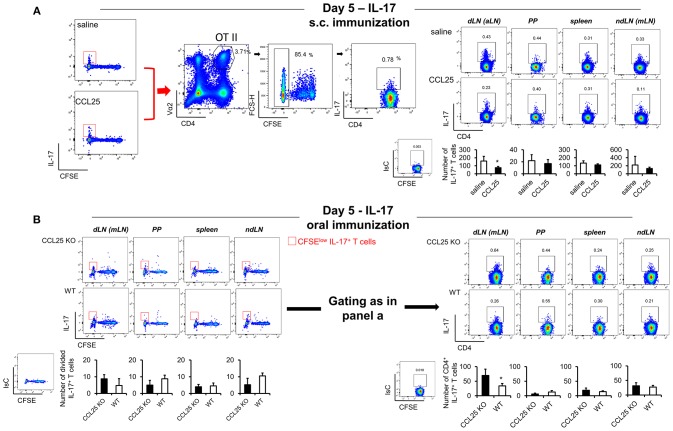
CCL25-induced TRM cells reduce differentiation of IL-17-producing T cells. OT-II naive T cells were labeled with CFSE (4 μM) and injected intravenously into syngeneic recipients (107/mouse), which were immunized 3 h later by s.c. (A) or oral (B) administration of 0.5 μg OVA-DEC plus 50 μg poly IC adjuvant (InvivoGen) re-suspended in saline solution or in the presence of CCL25 (0.06 mg/kg). T cells were separately harvested from draining LN (axillary, dLN), mesenteric LNs (mLNs), Peyer's Patches (PPs) and spleen 5 days later. Expression of IL-17 by T cells was assessed by flow cytometry by gating on CD4+Vα2+ (OTII TCR) CFSElow T cells. For clarity, the plots displaying CFSE dilution on divided T cells are shown on the left-hand-side of each panel, in which the red squares indicate the gate used for detection of IL-17+ T cells. The mean values obtained in at least three experiments of identical design are shown below each set of representative dot plots (±SD, n = 3). *p < 0.05.